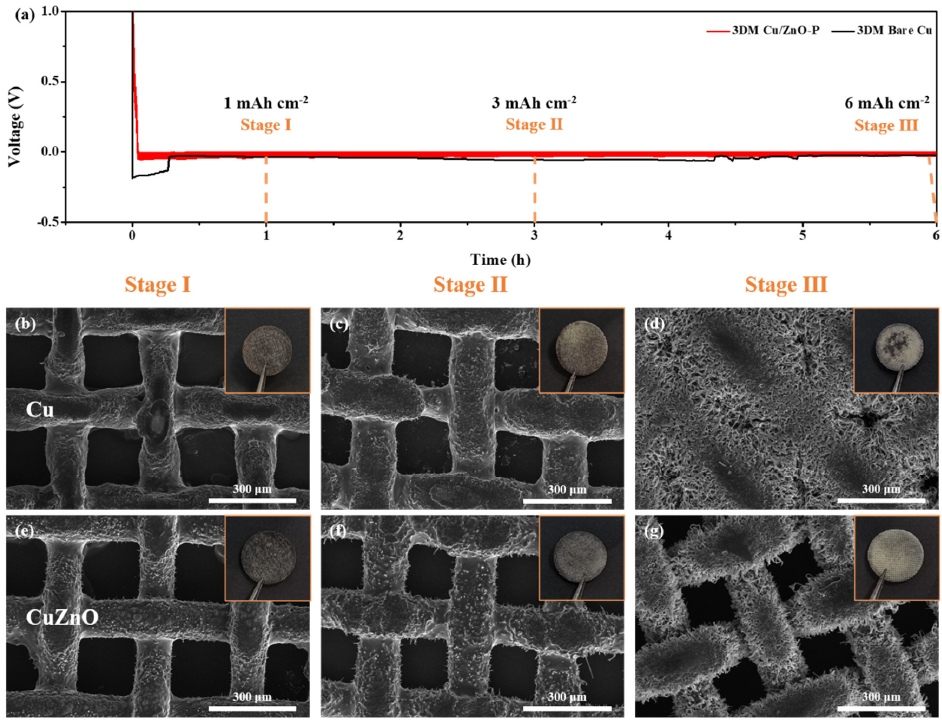
Figure 2. ( a ) The voltage distribution pro fi les of Li||Cu and Li||Cu/ZnO cells upon galvanostatic Li deposition. SEM images of ( b – d ) 3DM Bare Cu and ( e – g ) 3DM Cu/ZnO current collectors along 1 (stage Ⅰ ), 3 (stage Ⅱ ), and 6 mAh cm − 2 (stage Ⅲ ) of lithium deposition. The insets show the